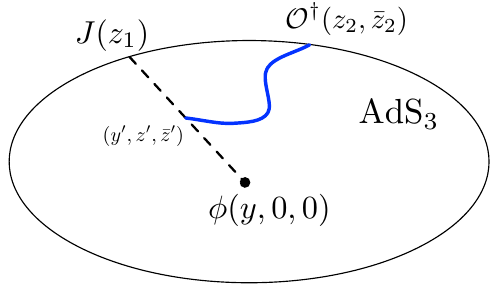
Figure 4 . Witten diagram for